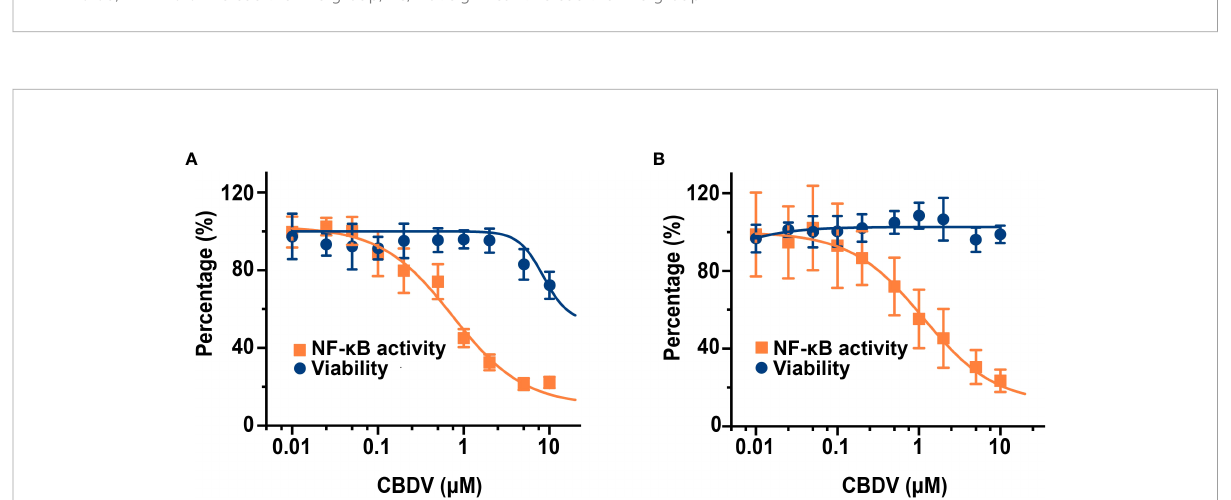
FIGURE 4 CBDV inhibits LPS-induced NF- k B activation in HEK Blue hTLR4 cells (A) and immunocompetent microglial BV-2 cells (B) . (A) HEK Blue hTLR4 cells, which overexpress human CD14, TLR4, and MD-2, were stimulated with LPS and indicated concentrations of CBDV. The NF- k B activity was determined by SEAP assay and the cellular viability was measured by CCK-8 Kit. (B) BV-2 NF- k B luciferase reporter cells were treated with LPS and indicated concentrations of CBDV. The NF- k B activity was determined by the Steady-Glo luciferase assay and the cellular viability was measured by crystal violet staining. All experiments were performed three times independently, and data were given as the mean ±